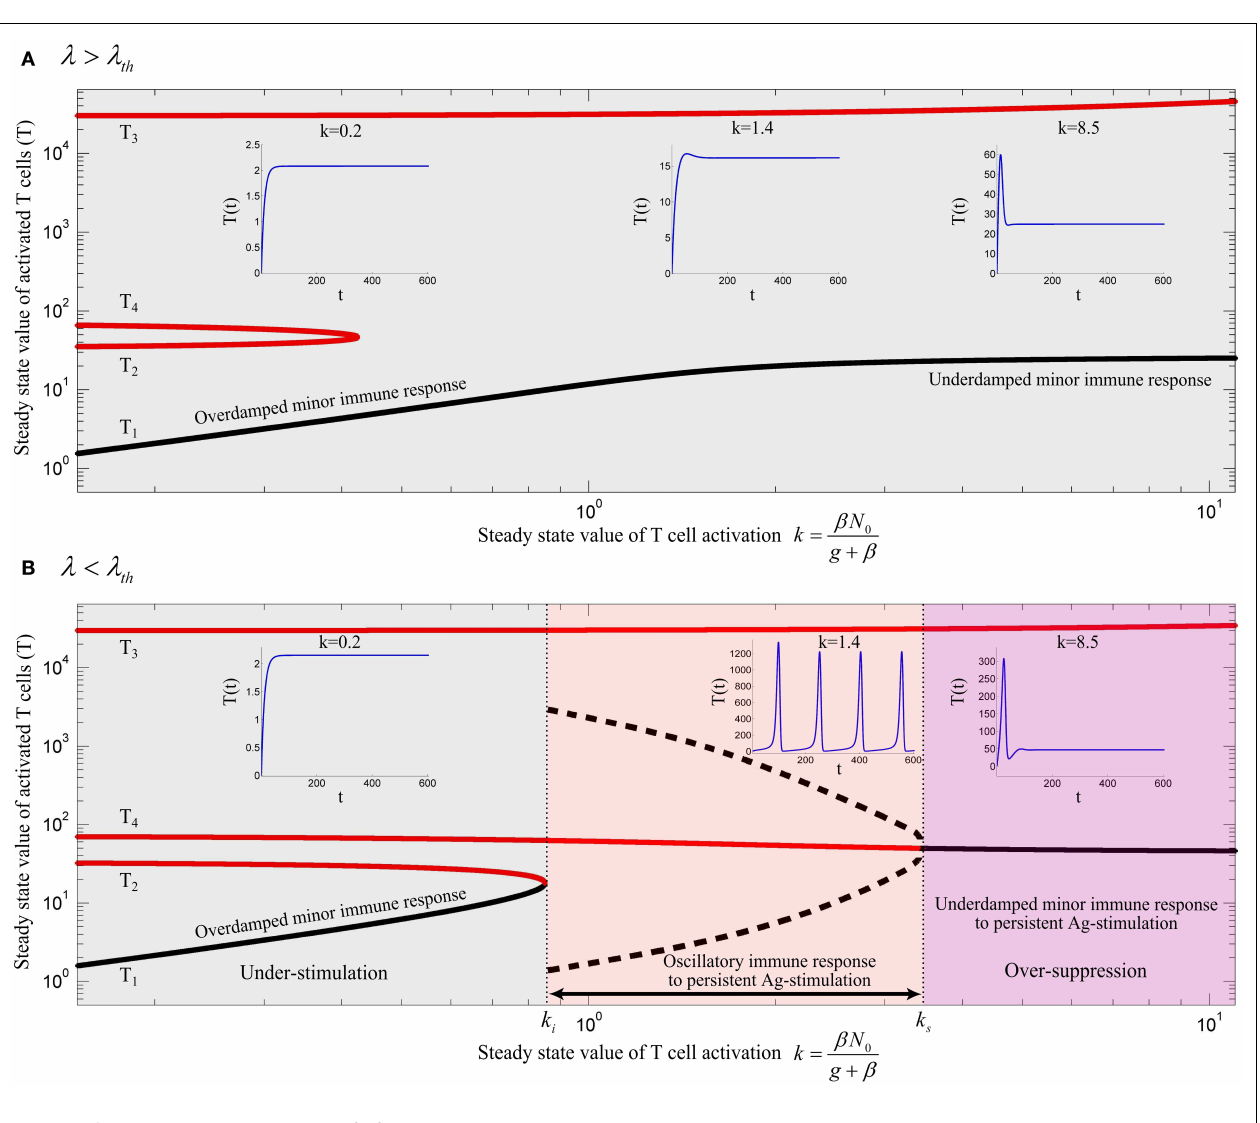
FIGURE 5 | Bifurcation diagram of model (13) using k as the bifurcation parameter with (A) λ = 0.02 and (B) λ = 0.006 . Stable and unstable equilibrium points are drawn by black and red solid lines, respectively. Dashed black lines represent the stable limit cycles by showing the maximum and minimum populations of oscillating activated T cells for persistent k . Depending on the values of λ and k , an immune